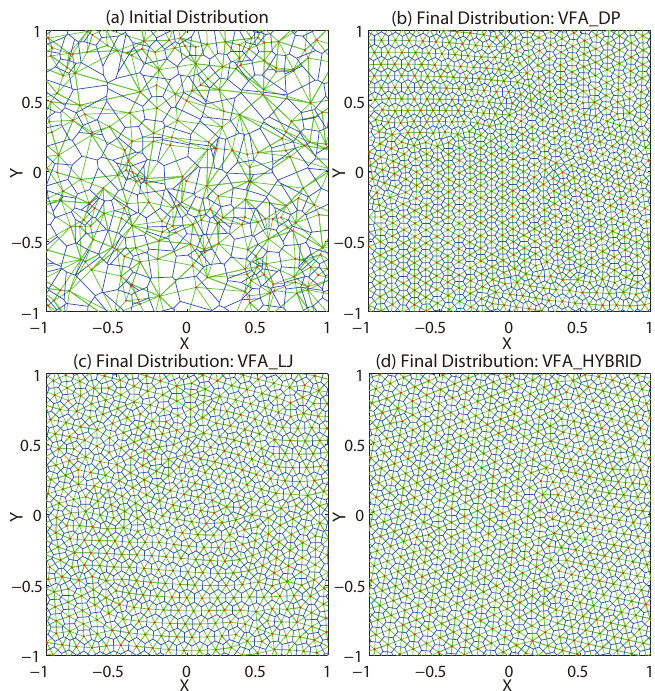
Figure 2. Network topology located within the central square area: ( a ) initial node distribution; ( b ) final node distribution from VFA-DP algorithm; ( c ) final node distribution from VFA-LJ algorithm; and ( d ) final node distribution from VFA-Hybrid algorithm.